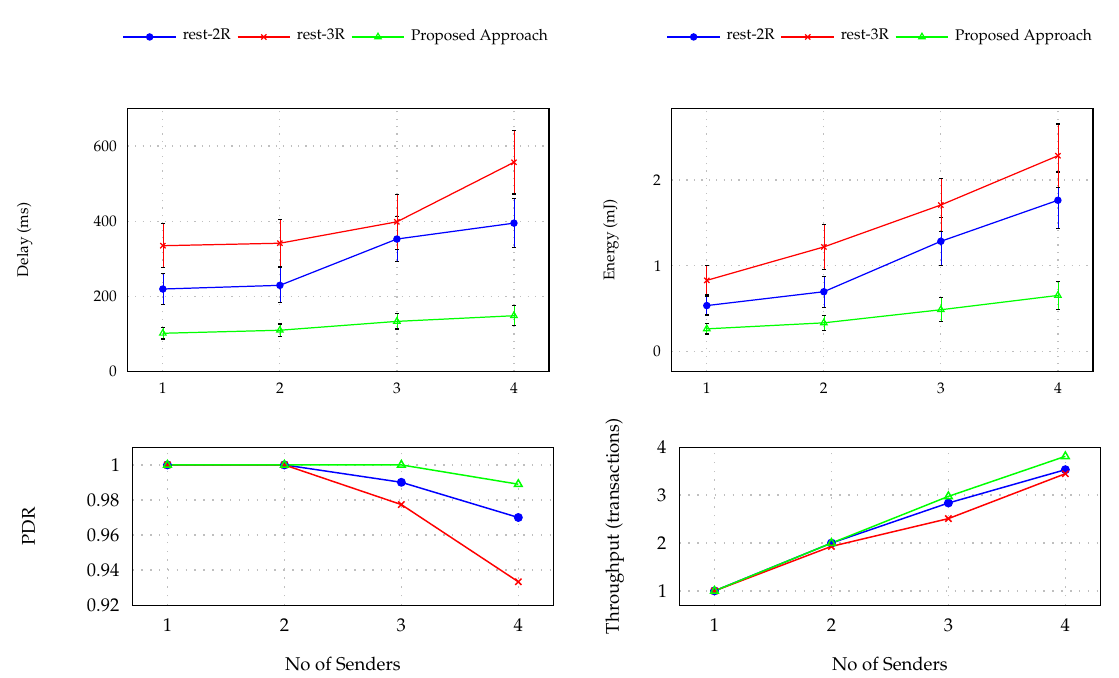
Figure 11. Scenario 2: Delay, energy consumption, packet delivery ratio (PDR), and throughput on different